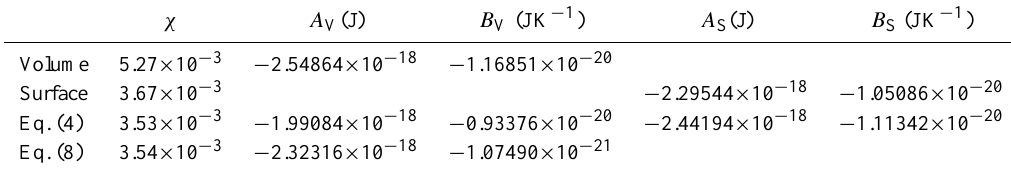
Table 2. Parameters from the best simultaneous fit to results from a group of experiments with small, medium and large aerosols using the microphysical model with freezing by volume and/or surface nucleation. The last row contains data discussed in Sect.